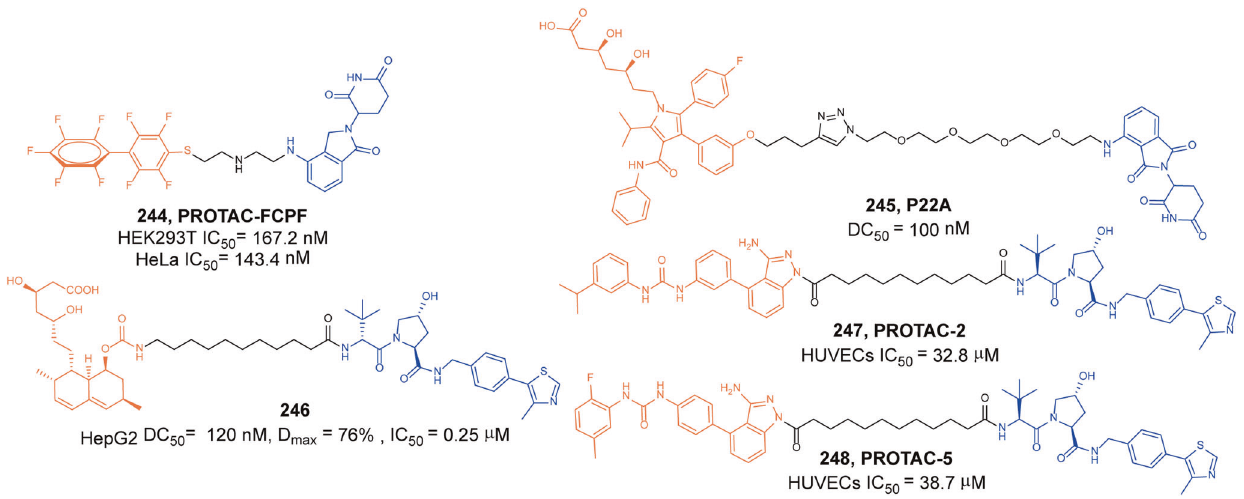
Fig. 81 The representative PROTACs targeting Cas protein, HMGCR and